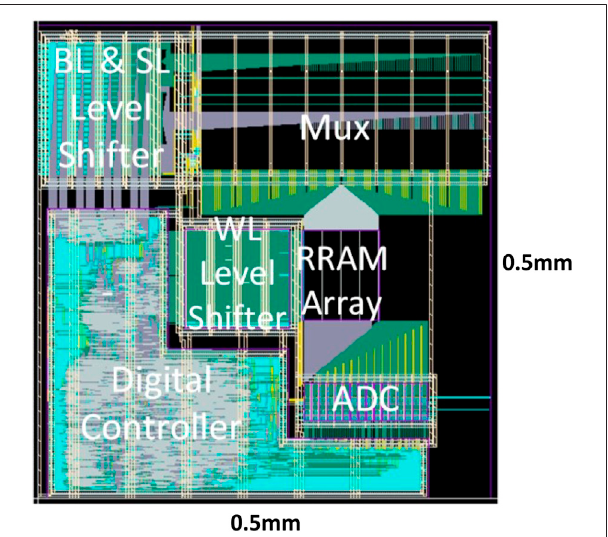
FIGURE 7 | CIM macro layout implemented with TSMC 40 nm RRAM